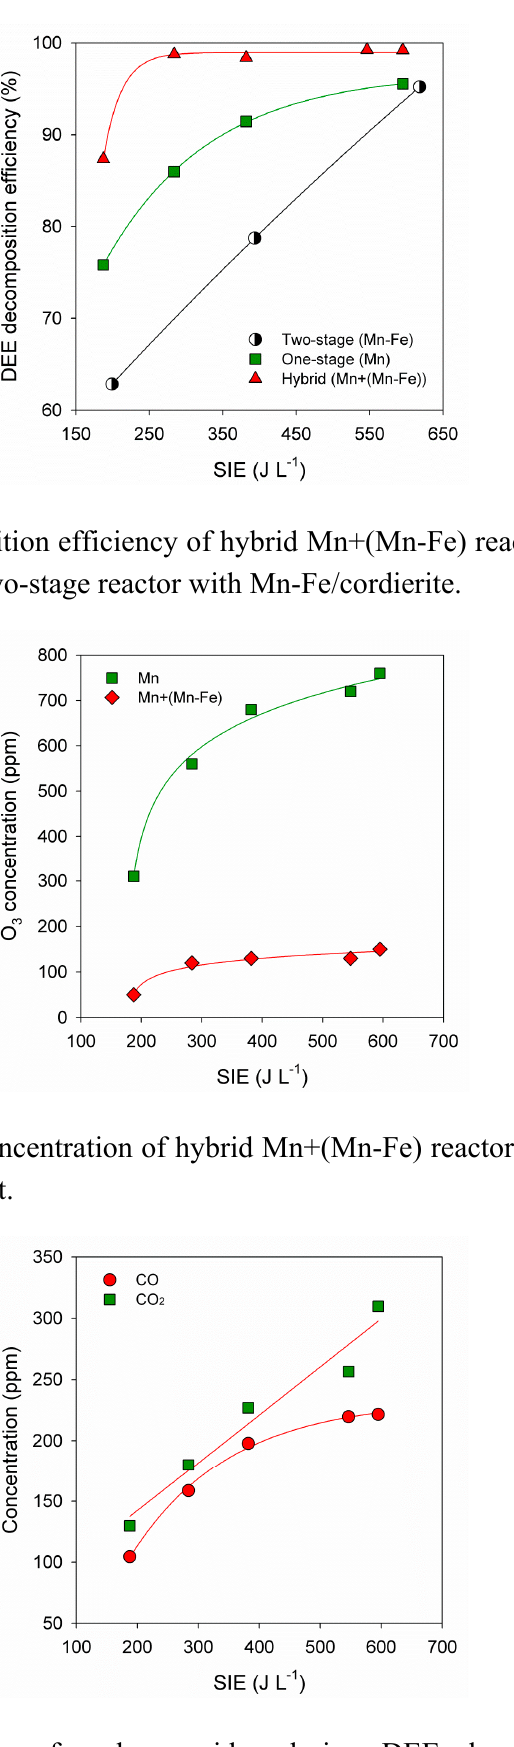
Figure 9. Concentrations of carbon oxides during DEE decomposition in hybrid Mn+(Mn-Fe)